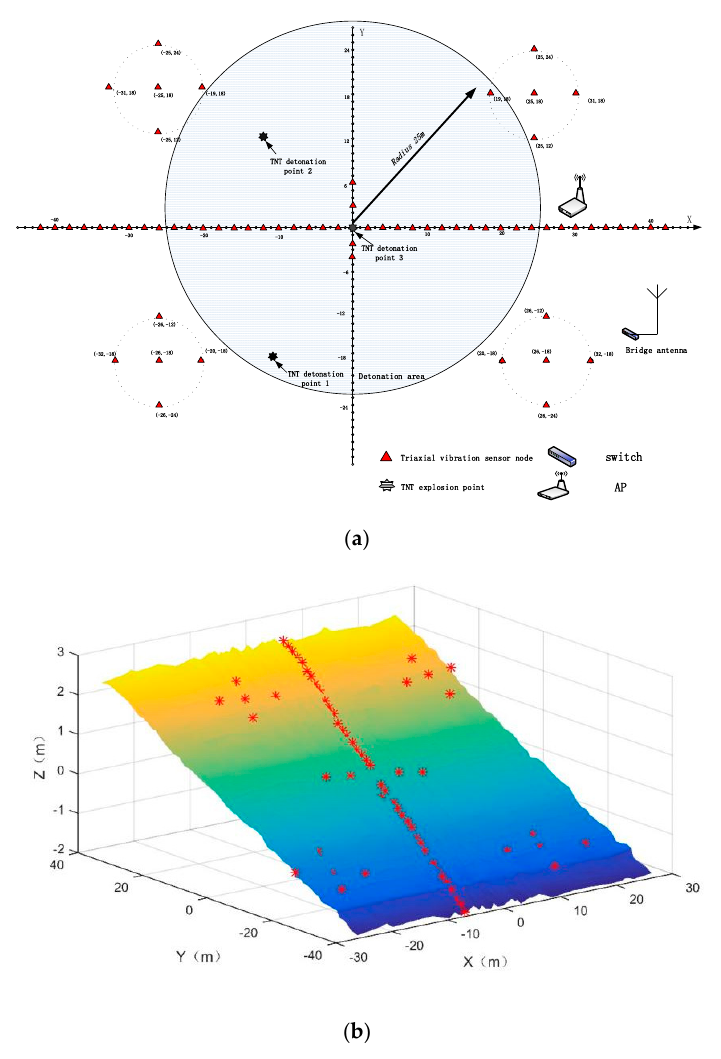
Figure 27. Layout of the sensors: ( a ) plane layout of the sensors and ( b ) actual position coordinates of the sensors and topographic map.